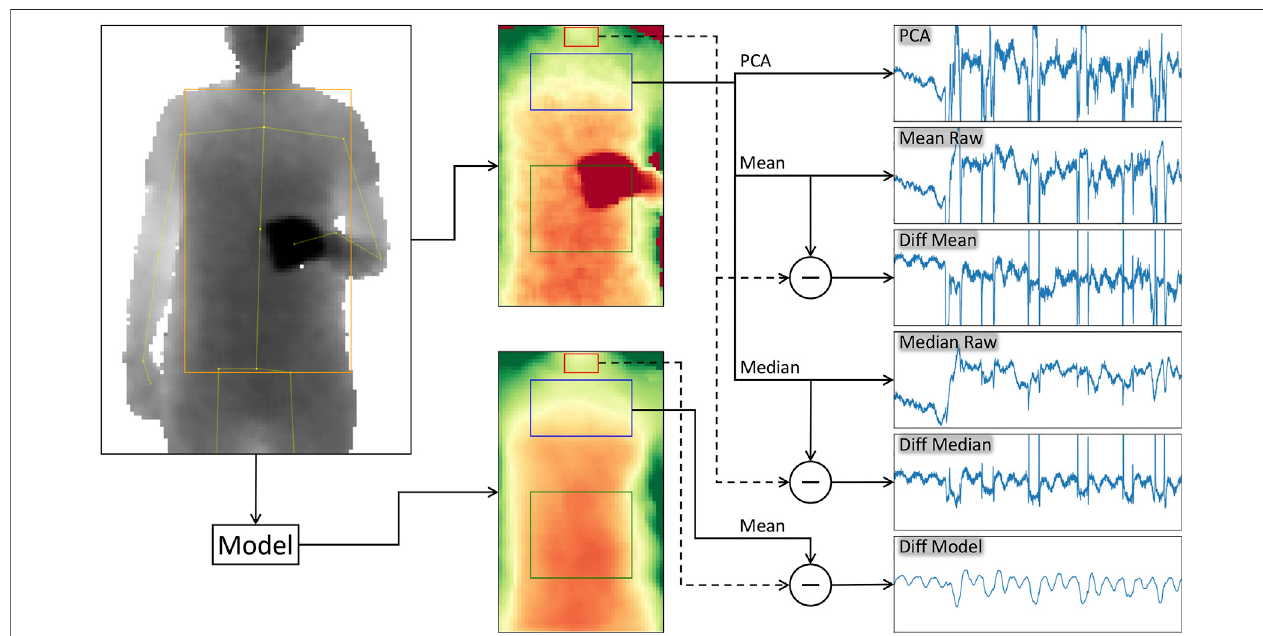
FIGURE2| Overviewofthemethodsused.Theexampleistakenfromadistanceof3 m,withtheuserstandinguprightandperformingregularselfocclusionswith acupinhishands.Theprocessstartswiththecamera ’ sdepthinputframeandtheestimatedjointpositionsoftheuser (topleft) .Bothareeitherforwardedtoamodelas proposed in Kemp fl e and Van Laerhoven (2020) (bottom left) to reconstruct the torso surface and fi nd the regions of interest (bottom mid) or the joint positions are used directly to fi nd the regions ofinterest (top mid) . In the latter case, the torso surface isredrawn forcomparison purposes tothe model output(middle images). The model is able to fi lter out most of the noise and to recover occluded torso regions. The regions of interest are the throat (red), the chest (blue), the abdomen (green), andthetorso(chestandabdomenwindowscombined,includingtheregioninbetweenboth,notdrawnintheimages).Thedepthpixelvalueswithinthedifferentregions, inthisexamplethevaluesofthechestand,dependingonthemethod,thethroatregion,areusedtocomputeasinglerespirationstatevalue.Therespirationsignalthenis givenbythehistoryofthesevalues.Ontherightaretheplotsoftheresultingbreathingsignalsofthedifferentmethods.Fromtoptobottom:ThesignalofthePCA,Mean Raw, Diff Mean, Median Raw, Diff Median, and the Diff Model. The PCA uses the fi rst 180 input frames (6 s) to compute the principal components, the respiration signal theniscomputedfromthe fi rstcomponentofthePCAmodel. TheMeanRawand MedianRawmethods computethemeanorthemedianofthedepthvalueswithinthe given torso region, for instance the chest as shown here. The Diff Mean and Diff Median methods on the other hand use the 90th percentile of the throat region depth valuesasreferencefortheusermovementandsubtractitfromtherespectivevaluesobtainedbytheirMeanRaworMedianRawcounterparts.Theirsignalscontainless distortions stemming from body movements, like swaying. The Diff Model method does the same, but computes the difference from the mean of the selected region of the model output. Its breathing signal is much smoother and barely contains distortions or spikes stemming from motion artifacts and occlusion events.